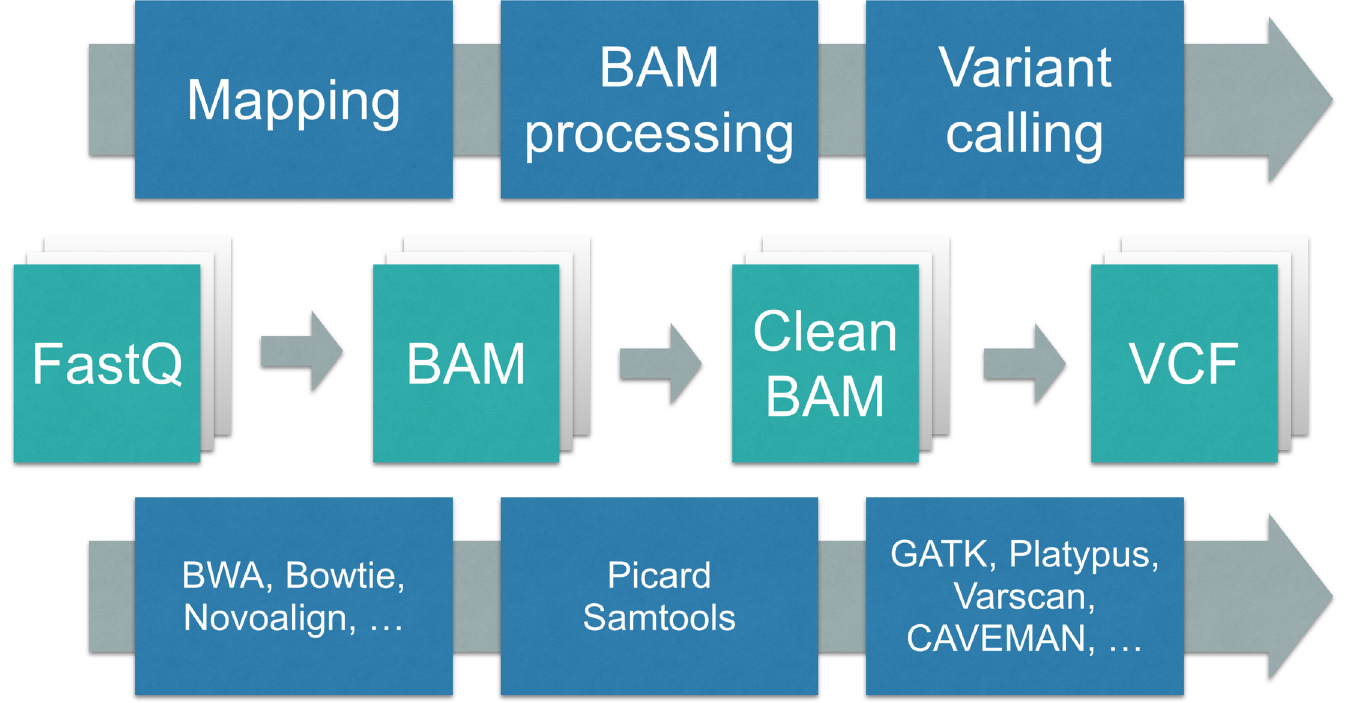
Fig 1. The computational phases of DNA sequencing. First, the reads produced by the wet lab (in FastQ format) are aligned against a reference genome, producing a sequence alignment map file (SAM). Then this SAM file is processed so that it can be used by an analysis tool to produce a VCF file.